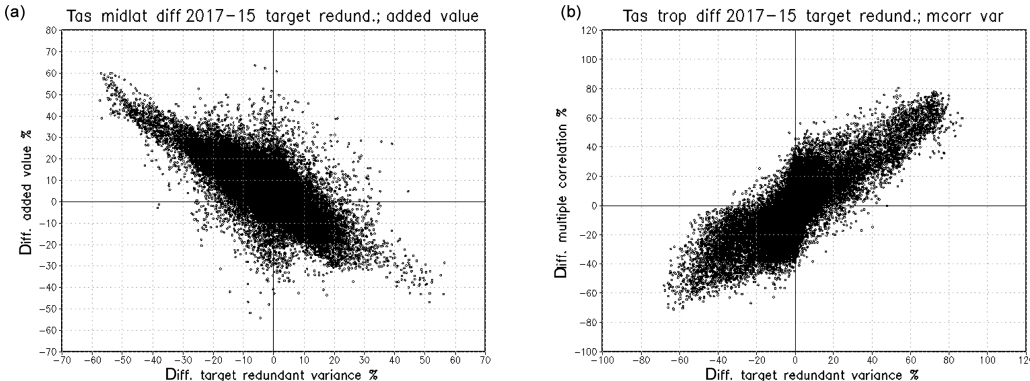
Figure 7. Scatter diagrams in which the target redundance differences between the winters of 2016–2017 and 2014–2015 of 4d dynamic and damped lag day − 4 persistence forecasts are assigned to the x axis, and the differences in added values of 4d dynamic forecasts for 120 ◦ E, 120 ◦ W, and 30–70 ◦ N are assigned to the y axis (a) . The differences in the multiple correlations of 4d dynamic and damped lag day − 4 persistence forecasts hemispherically for 10 ◦ S to 10 ◦ N are assigned to the y axis in (b) . The Pacific Ocean extratropics are excluded in (a) because they behave more like the tropics, probably because they are influenced by El Niño–Southern Oscillation (ENSO). In the extratropics, increases and/or decreases in damped persistence, here seen as target redundance changes, are balanced by opposite decreases and/or increases in added values. In the tropics, however, increases and/or decreases in damped persistence lead to increased and/or lower forecast quality or multiple